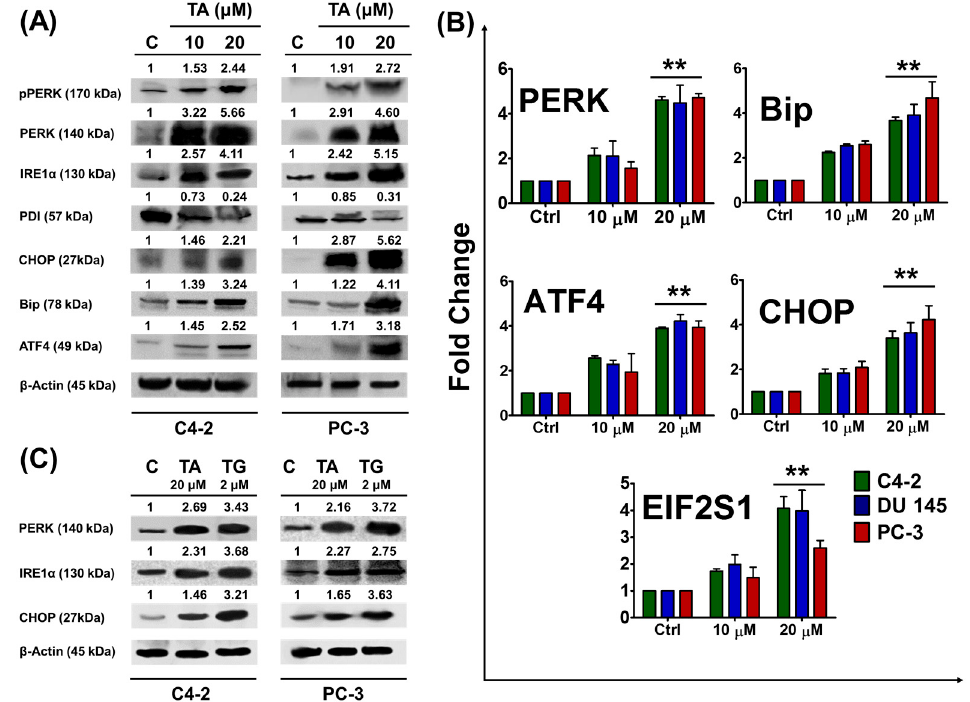
Figure 2. Tannic acid induced ER stress in prostate cancer cells. ( A ) Western blot analysis of Protein kinase R-like endoplasmic reticulum kinase (PERK), inositol requiring enzyme 1 alpha (IRE1 α ), and activating transcription factor 4 (ATF4) signaling in prostate cancer cells after dose-dependent treatment with TA. Briefly, cells were treated with indicated concentrations of TA, protein extracts were prepared and subjected for western blot analysis to detect the protein levels. β -Actin antibody served as an internal control; ( B ) Gene expression studies endoplasmic reticulum (ER) stress markers in TA treated cells for PERK , eukaryotic translation initiation factor 1 (EIF2S1 ), binding immunoglobulin protein ( BiP ), transcription factor C/EBP, homologous protein (CHOP ), and ATF4 determined by qRT-PCR analysis. GAPDH was used as an internal control. Data represent the mean of triplicates ± SEM, ** p < 0.01; ( C ) Cells were grown and exposed to TA and Thapsigargin. Western blot analysis of regulatory protein expression of ER stress in TA and thapsigargin (TG) treated C4-2 and PC-3